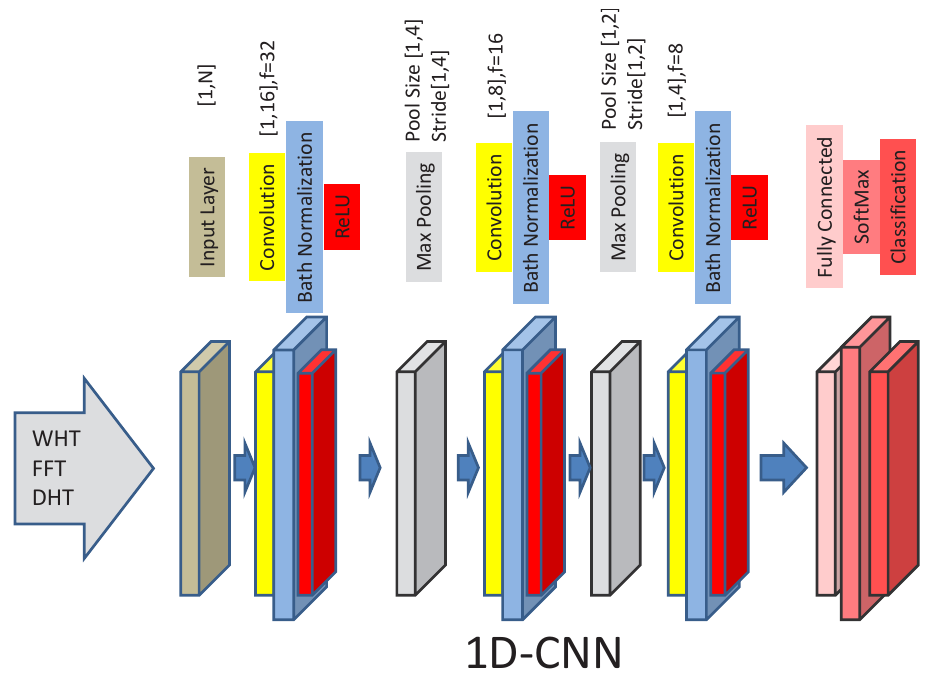
Figure 3. Architecture of the Convolutional Neural Network used in the study for the WHT, FFT, and DHT